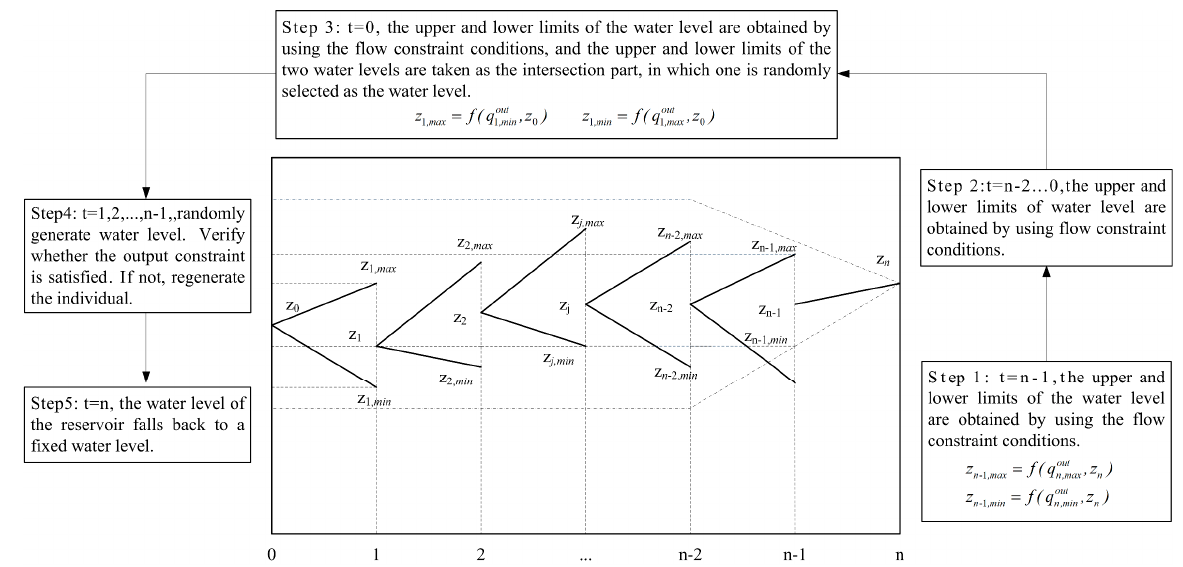
Figure 2. Flow chart of shrinking the feasible search space.